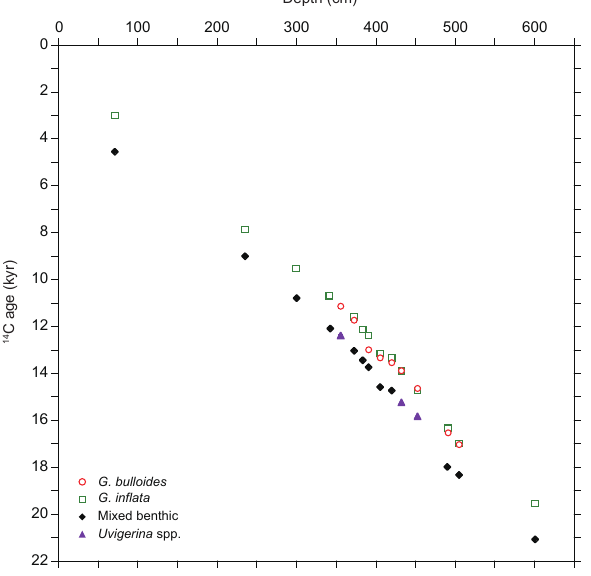
Fig. 4. Okazaki et al. Fig. 4. 1 14 C change during the last 25kyr in core MD01-2420 (red symbols) and in the western North Pacific between 900 and 2800m water depths (grey symbols; Duplessy et al., 1989; Mu- rayama et al., 1992; Ahagon et al., 2003; Broecker et al., 2004b; Minoshima et al., 2007; Broecker et al., 2008; Sagawa and Ikehara, 2008). Orange and blue curves are atmospheric (Intcal09) and sur- face ocean (Marine09) 1 14 C records (Reimer et al., 2009), respec- tively. Red square is present 1 14 C value at MD01-2420 site (Key et al., 2004). Yellow band represents the Heinrich Event 1 between 14.6 and 17.5kyr